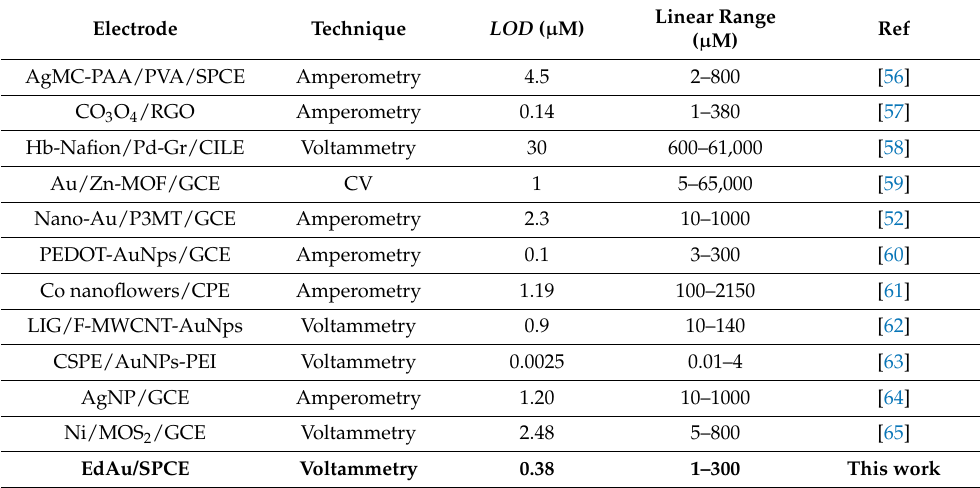
Table 2. Performance comparison of the electrodes developed in this study with other electrodes from the